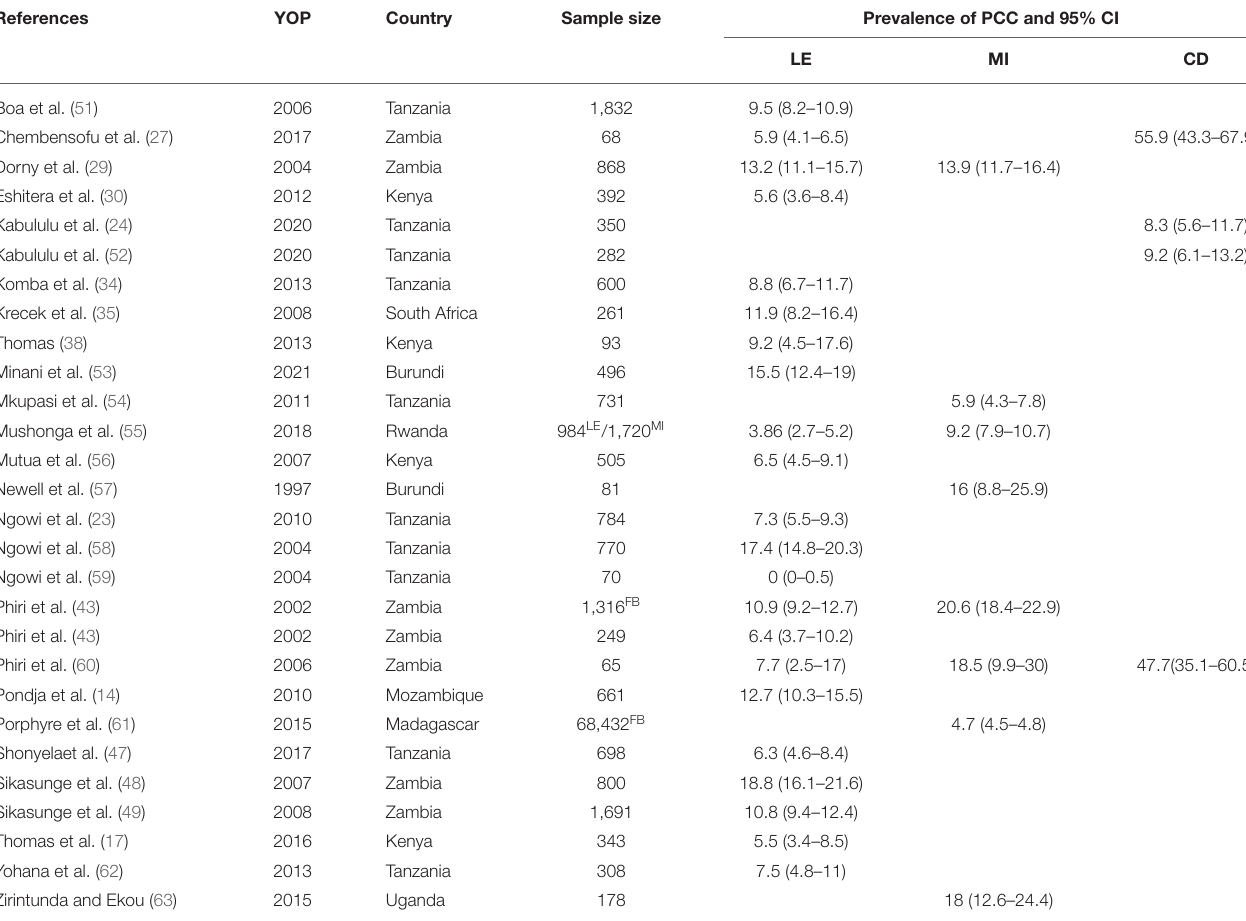
TABLE 2 | Prevalence of porcine cysticercosis based on Lingual examination, meat inspection, and carcass dissection